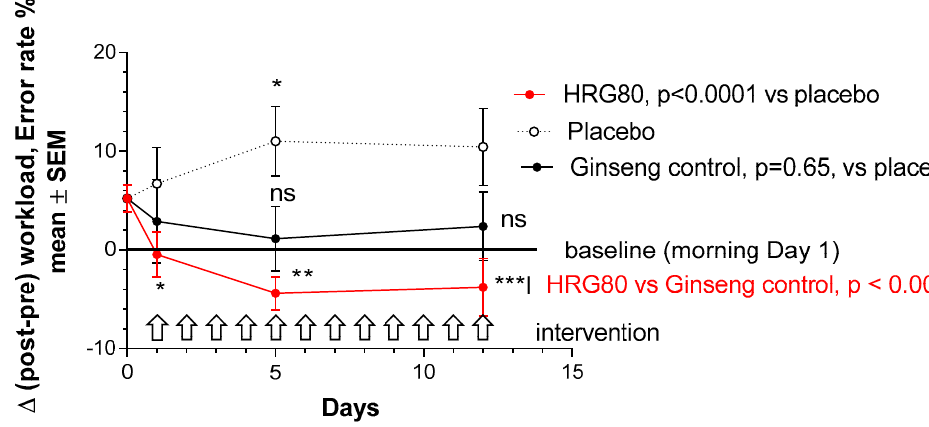
Figure 1. Dynamic changes of post–pre-workload, accuracy score. Changes in attention with time at Days 0, 1, 5, and 12 in placebo, ginseng HRG80, and ginseng control treatment groups. Significance of changes shown by symbols * p < 0.05, ** p < 0.01, *** p < 0.001; ns, not significant. Between-group change comparison over time shows significant di ff erence between ginseng HRG80 and ginseng control treatments ( p < 0.0001, n = 50 in each group), ginseng HRG80, and placebo treatments, but no significant di ff erence between positive and negative controls.